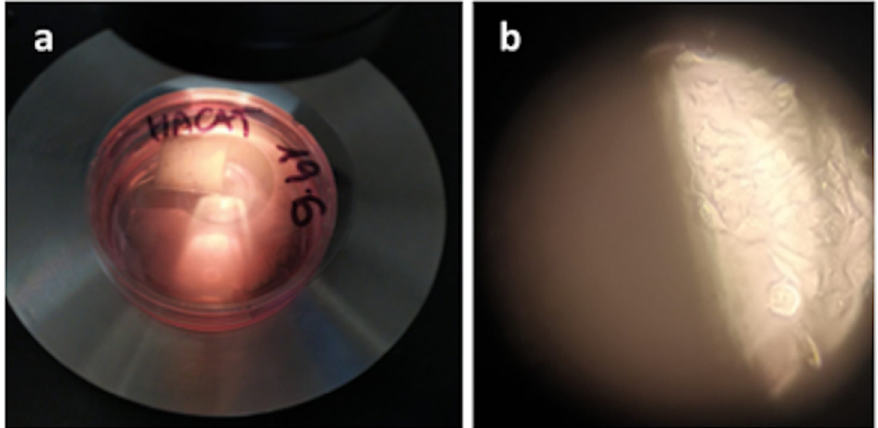
Figure 6. ( a ) HaCat cells culture on the titanium plate coated with poly-L-lysine. ( b ) After a further 48 h, the titanium plate with the adherent HaCaT cells was placed in a new well with a fresh medium, where vital and growing cells were appreciated adhering on the bottom of the well, as shown in figure ( b ) (optical microscopy, original magnification ×10).